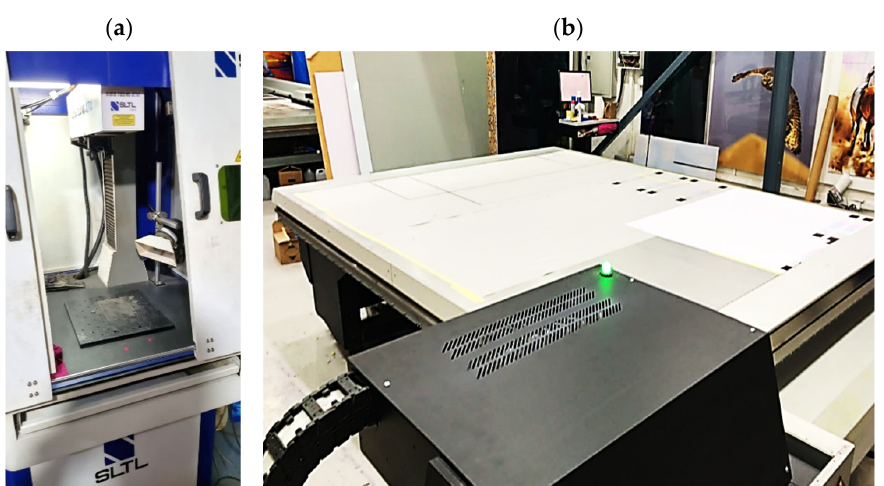
Figure 4. Checkerboard targets fabricated using ( a ) SLTL’s Akshar Fiber Pro Ultra laser engraving machine and ( b ) Canon’s Arizona 1380 XT flatbed UV printer. Table 2. Physical and thermal properties of the SS304 calibration plate.